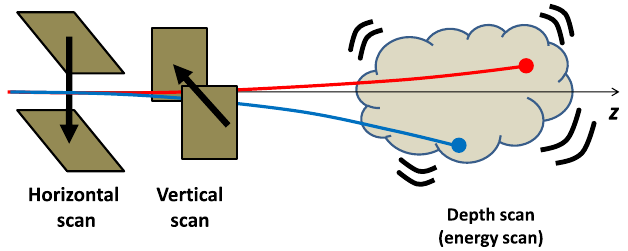
FIG. 2. 3D Schematic of a cancer site and scanning